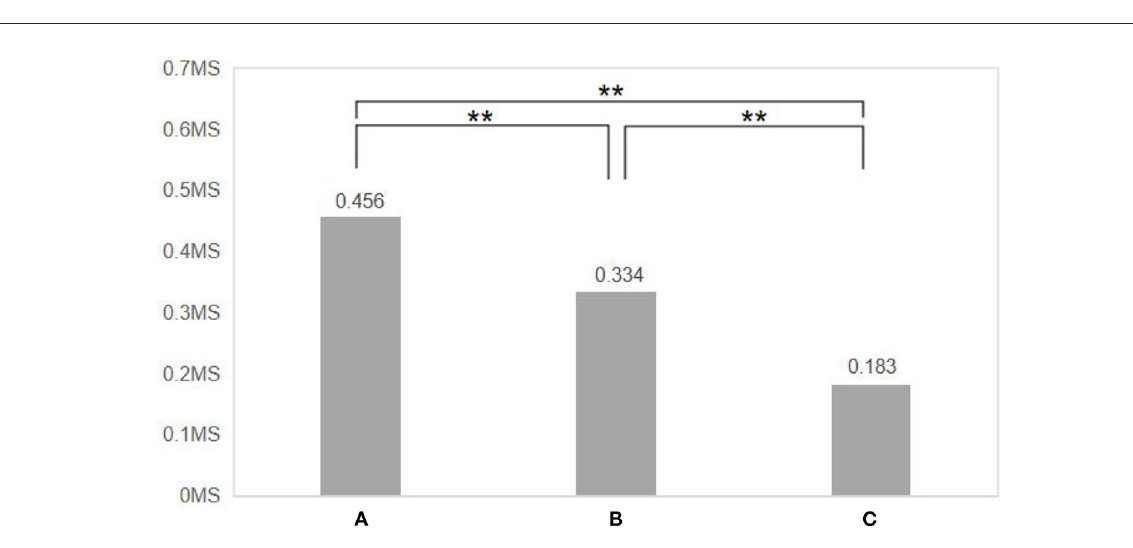
a lower rate of green vision, the emotional facilitation was significantly higher for males than for females. At the same time, male subjects in Scenario A and Scenario B also had slightly greater skin electrical differences than female subjects (Scenario A: 0.492 ± 0.385 for males and 0.424 ± 0.245 for females; Scenario B: 0.380 ± 0.164 for males and 0.291 ± 0.163 for females), suggesting that the residential courtyard space scenario had a greater emotional facilitation effect on